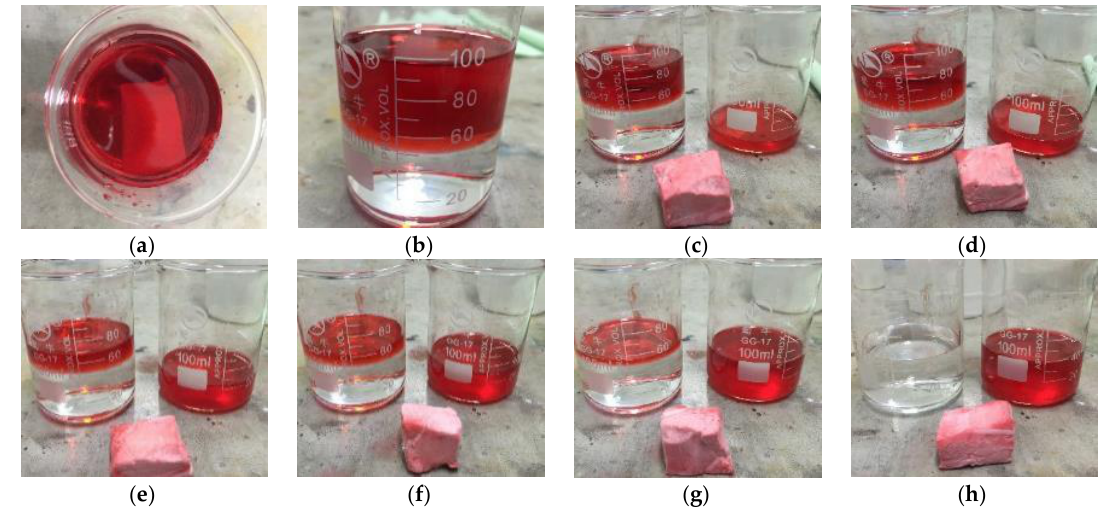
Figure 10. Digital camera images of oil/water separation experiment process; ( a ) aerogel in mixture; ( b ) aerogel in mixture; ( c ) first absorption; ( d ) second absorption; ( e ) third absorption; ( f ) fourth absorption; ( g ) fifth absorption; ( h ) sixth absorption.